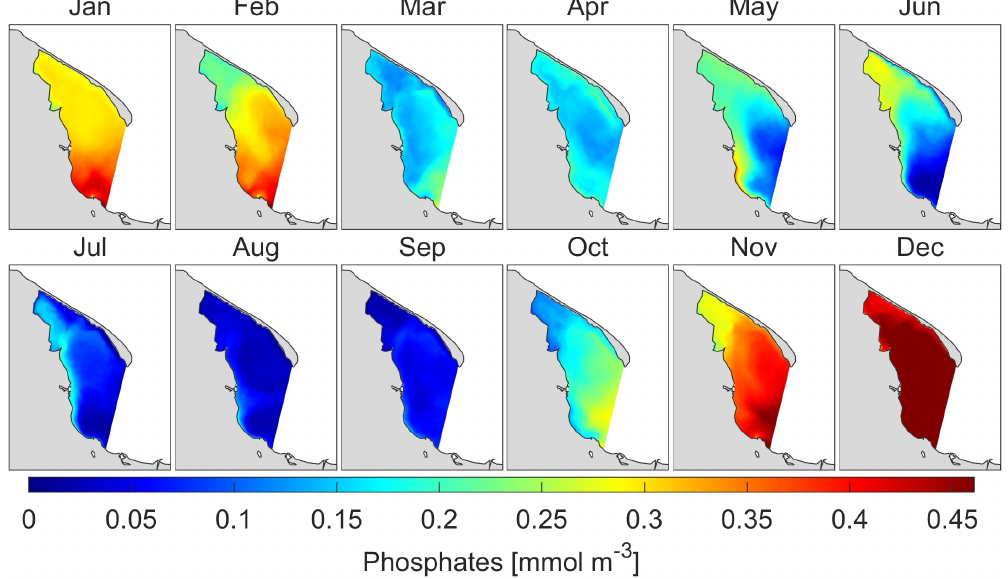
Figure 10. Monthly means of phosphates concentration at sea surface.